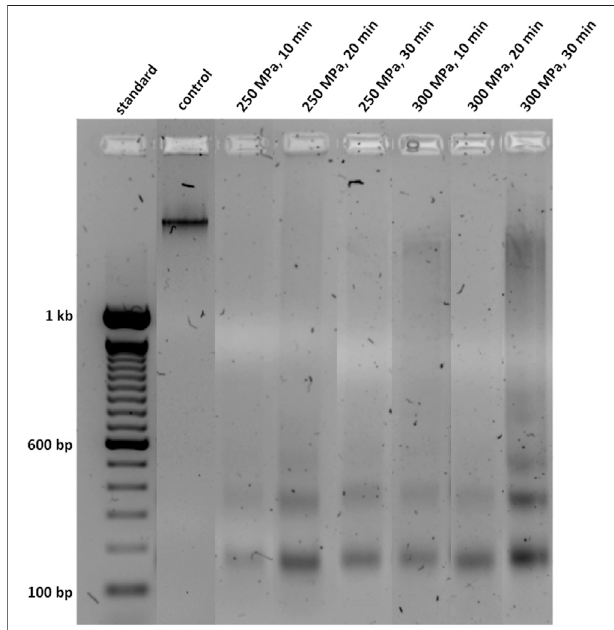
FIGURE 2 | Oligonucleosomal size fragmentation of DNA isolated from human trabecular bone. Shown samples were incubated for 1 h after HHP- treatment. DNA was separated using a 1.7% agarose gel and a voltage of 120